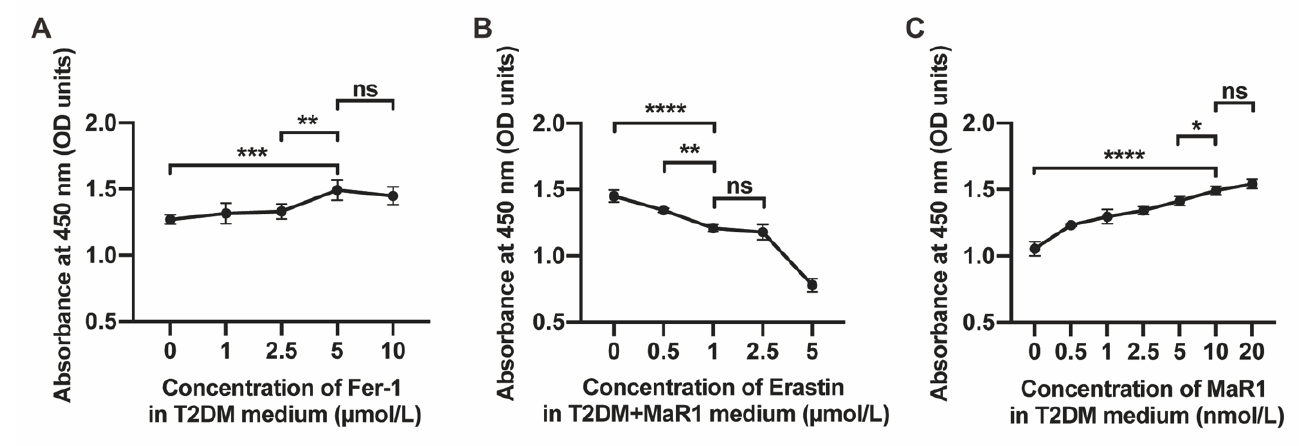
Figure A5. Dose-dependent experiment for Fer-1, Erastin, and MaR1 via Cell Counting Kit-8 assay. ( A ) Fer-1, at different concentrations, was separately added into the T2DM medium. The optimal concentration of Fer-1 to promote the viability of osteoblasts under high-glucose conditions was 5 μm. ( B ) Ferroptosis promoters (Erastin) impaired osteoblast viability, as shown in the Cell Counting Kit-8 assay. ( C ) In order to initially screen the in vitro application concentration of MaR1, we added MaR1 to the T2DM medium, ranging from 0 to 20 nM. Data are presented as the means ± SDs from three separate experiments (n = 3). ns p > 0.05; * p < 0.05; ** p < 0.01; *** p < 0.001; **** p < 0.0001.